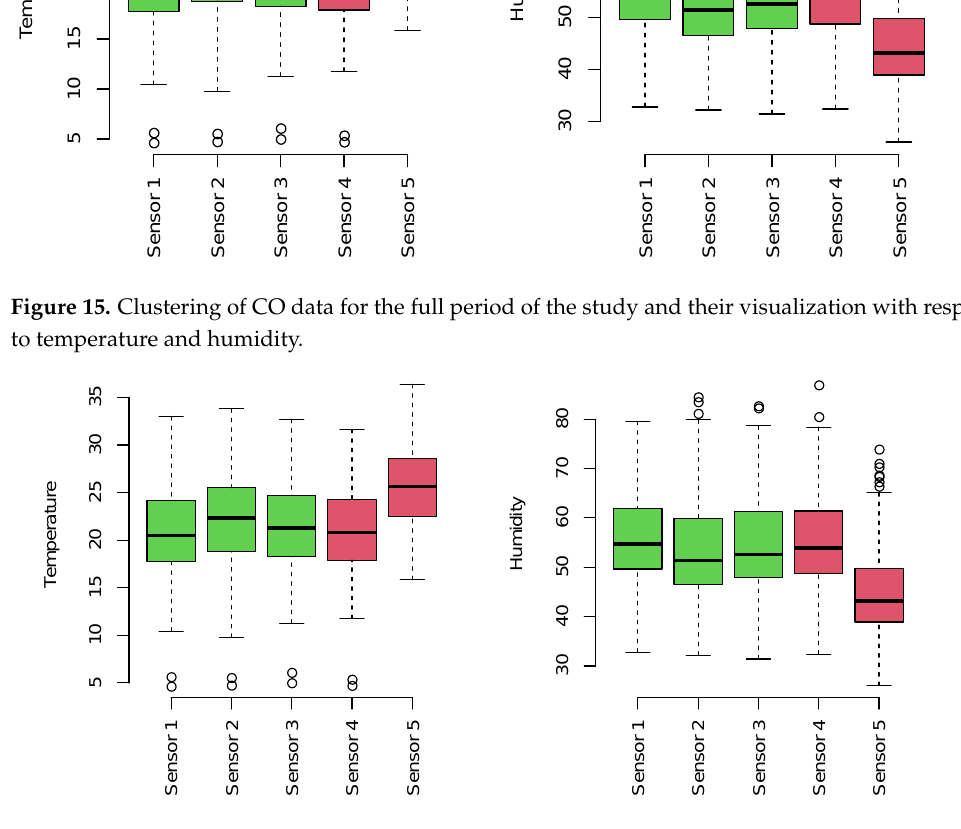
Figure 16. Clustering of NO 2 data for the full period of the study and their visualization with respect to temperature and